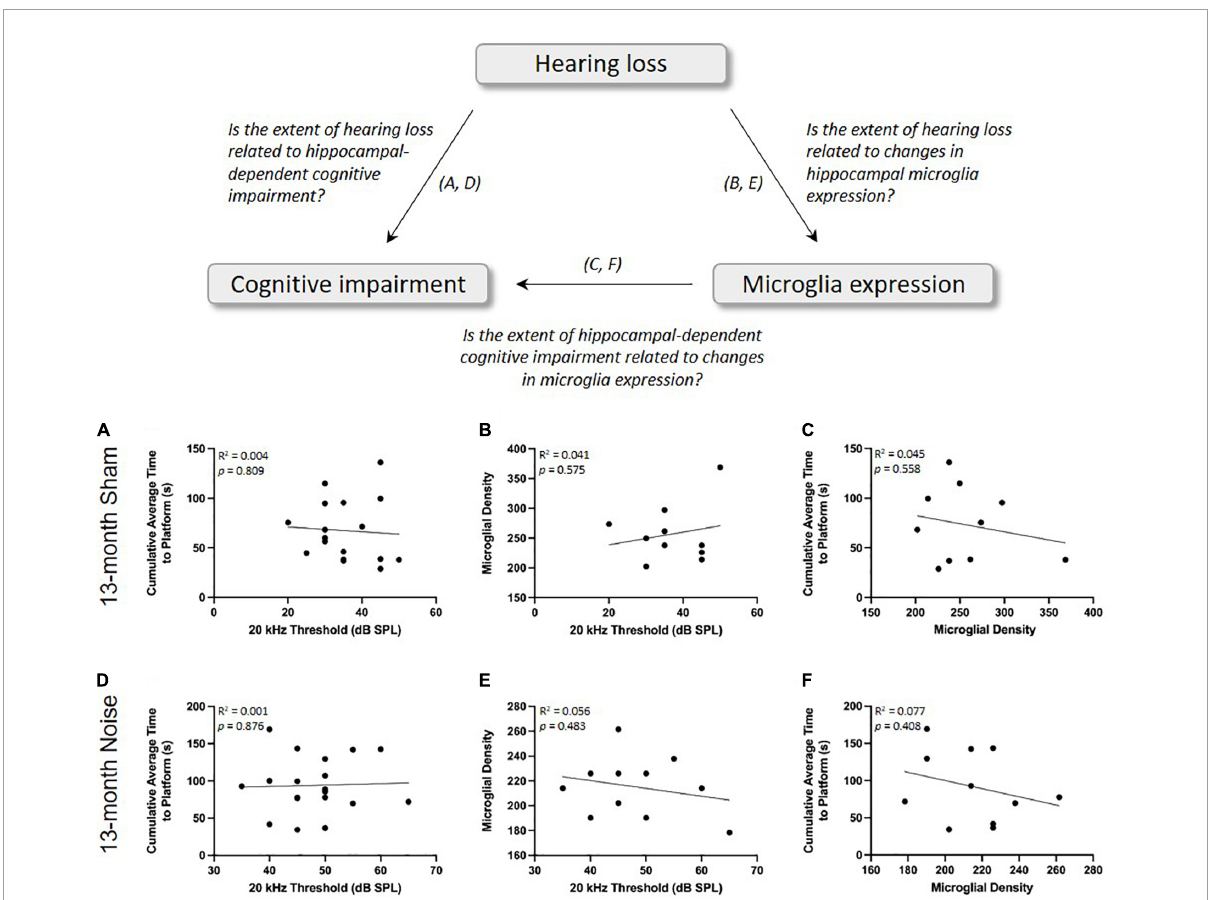
FIGURE6 There were no significant correlations between the degree of hearing loss, spatial learning impairments, and hippocampal microglial density in the 13-month-old rats. As determined by a linear regression, the extent of hearing loss was not a significant predictor of spatial learning ability (A,D) or hippocampal microglial density (B,E) for sham- or noise-exposed rats. (C,F) Hippocampal microglial density was also not correlated with spatial learning ability in sham- or noise-exposed